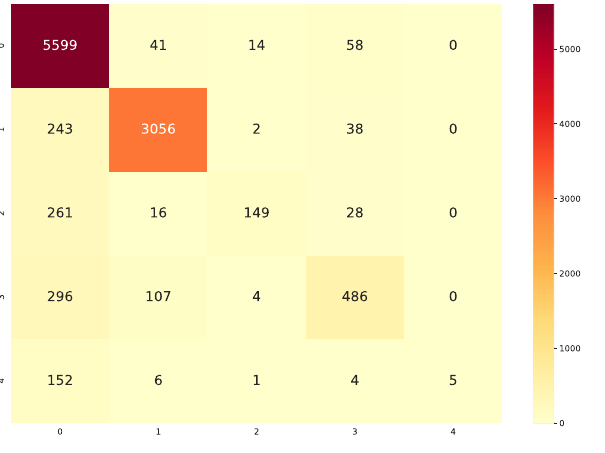
Figure 6: Confusion matrix made with the test data pro- duced by the FNN with multiclass classification. 0, 1, 2, 3 and 4 refer to the classes previously